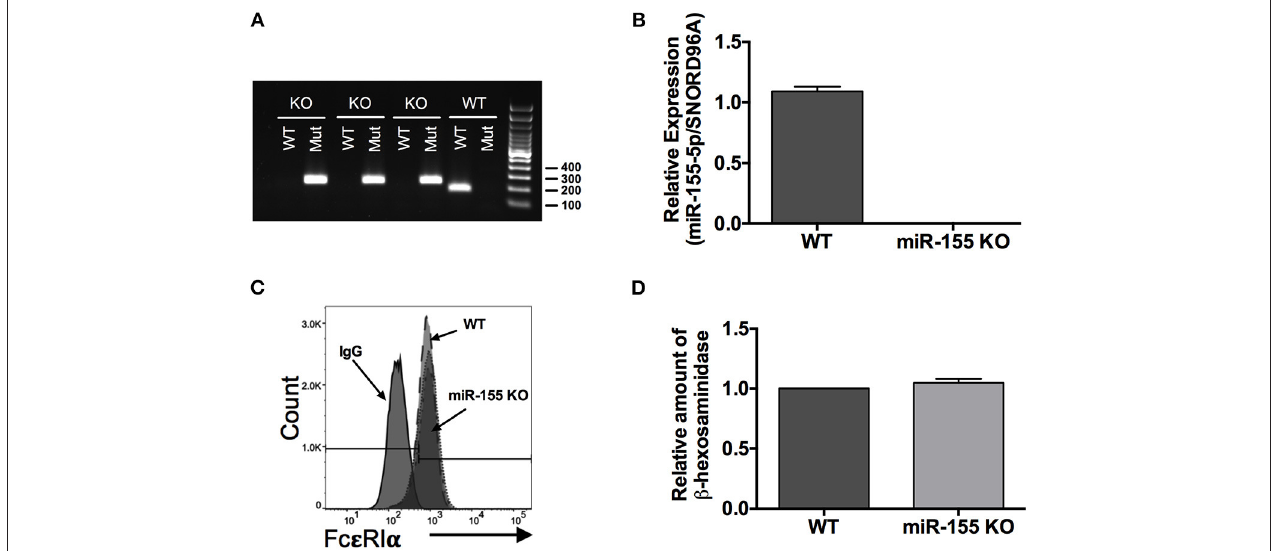
FIGURE 3 | Genotyping and characterization of miR-155 knockout (KO) BMMCs. (A) Representative DNA gel of PCR products. Genotyping was routinely performed on all BMMC cultures to confirm miR-155 deficiency. (B) Quantitative RT-PCR analysis of miR-155-5p expression in wild-type and miR-155 KO BMMCs. (C) Representative flow cytometry histogram of surface Fc ε RI expression on wild-type and miR-155 KO BMMCs. (D) Bar graph showing relative amount of total β -hexosaminidase in miR-155 BMMCs compared to wild-type BMMCs. The bar graphs represent mean ± SEM of values obtained from independent experiments with three different BMMC cultures from different mice. Significance was determined with Student’s t